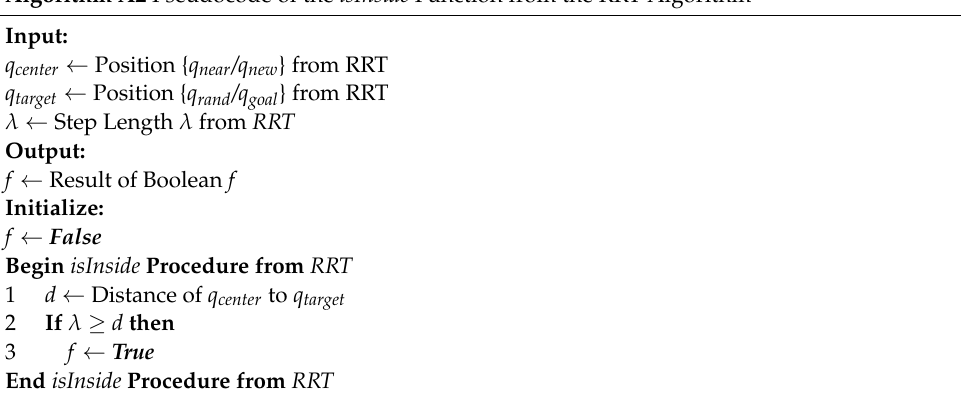
Algorithm A2 Pseudocode of the isInside Function from the RRT